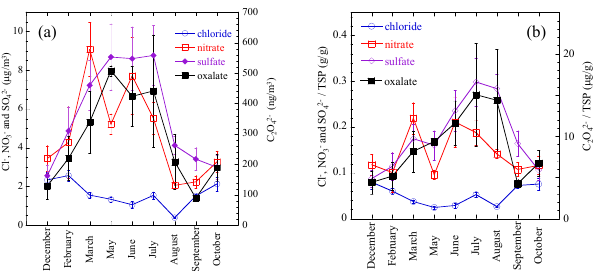
Fig. 2. (a) Concentrations of major anions in aerosol collected at Tsukuba; (b) concentrations of major anions at Tsukuba normal- ized by TSP concentration. The values are tabulated in Table S1. Error bars are standard deviations obtained by three independent